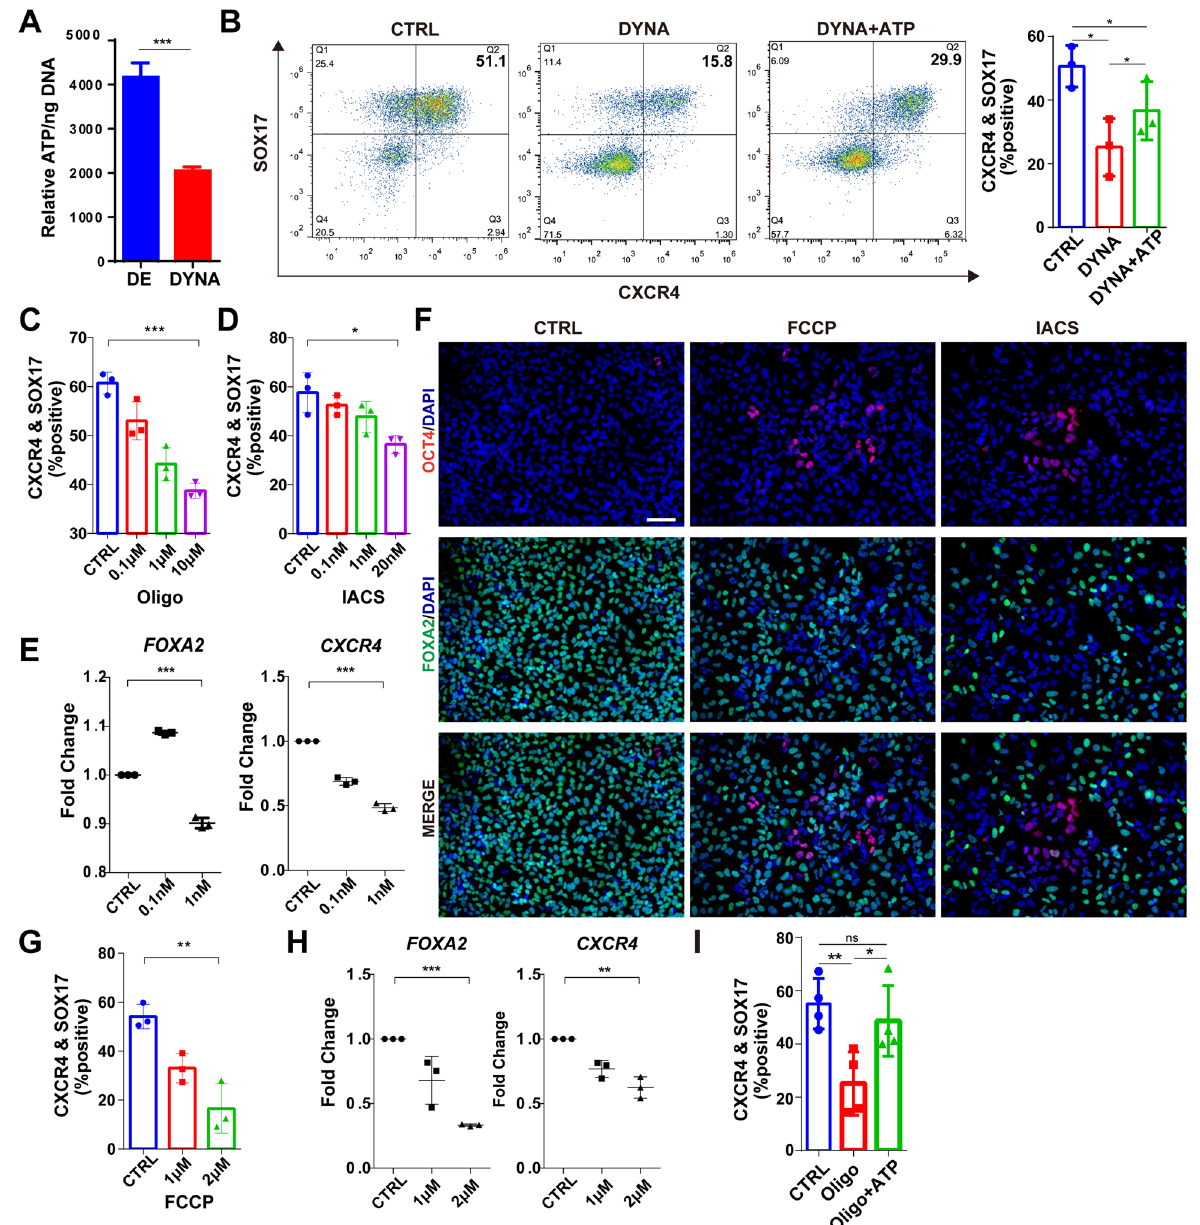
( n = 3). C Flow cytometry analysis to measure the percentage of CXCR4 and SOX17-positive cells in DE differentiation treated with oligomycin (oligo) ( n = 3). D Flow cytometry analysis to measure the percentage of CXCR4 and SOX17-positive cells in DE differentiation treated with IACS ( n = 3). E mRNA expression of endoderm factors FOXA2 and CXCR4 in DE cells treated with IACS ( n = 3). F Immuno fl uorescence microscopy of de fi nitive endoderm cells for FOXA2 (green) and OCT4 (red) treated with 2 μ M FCCP or 20 nM IACS. DAPI, blue. Scale bar = 400 μ m. G Flow cytometry analysis to measure the percentage of CXCR4 and SOX17-positive cells in DE differentiation treated with FCCP ( n = 3). H mRNA expression of endoderm factors FOXA2 and CXCR4 in DE cells treated with FCCP ( n = 3). I Flow cytometric analysis of CXCR4- and SOX17- positive cells in DE differentiation treated with 1 μ M oligomycin plus 0.5 mM ATP ( n = 4). The data of RT-PCR are normalized to the mRNA level of untreated (control) DE cells. All data are shown as mean ± SD. ns, not signi fi cant. * P < 0.05, ** P < 0.01 and *** P <